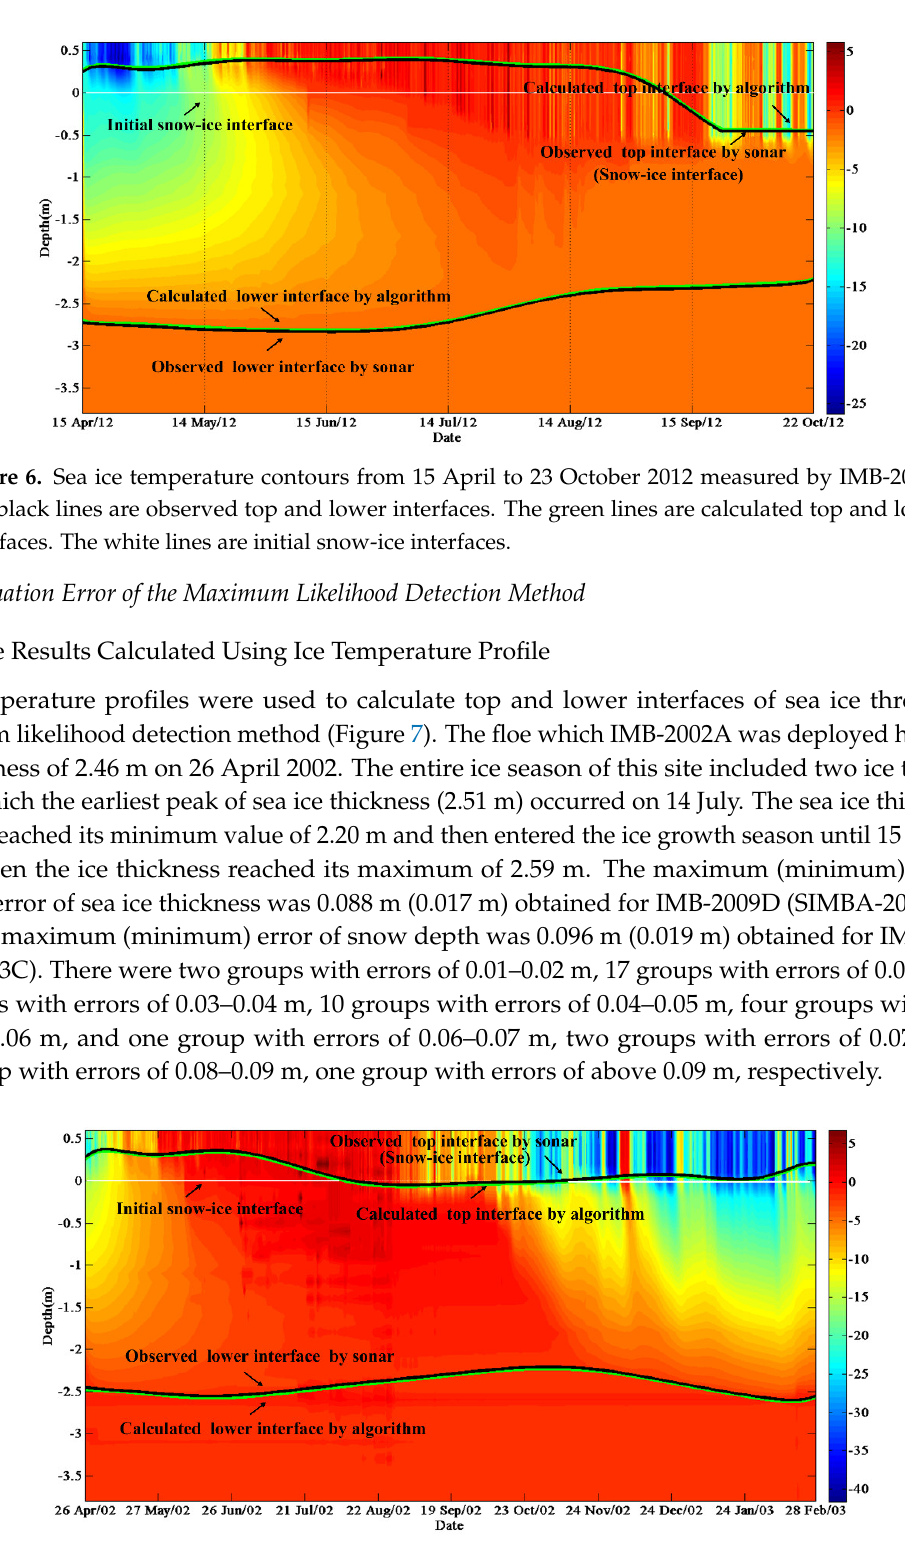
Figure 7. Sea ice temperature contours from 26 April 2002 to 23 February 2003 measured by IMB-2002A. The black lines are observed top and lower interfaces. The green lines are calculated top and lower interfaces. The white lines are initial snow-ice interfaces.